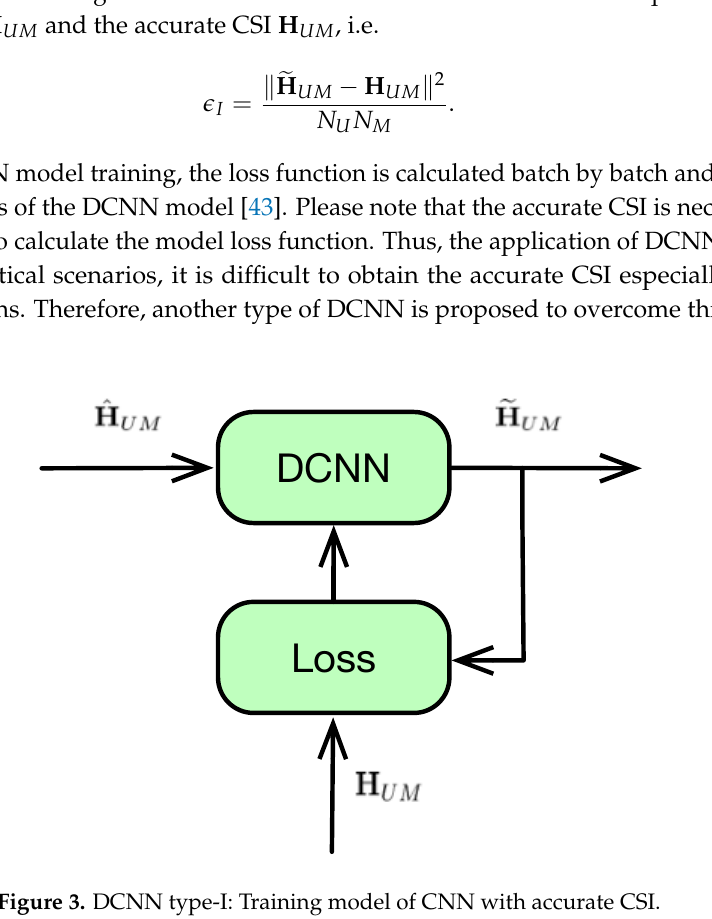
Figure 3. DCNN type-I: Training model of CNN with accurate